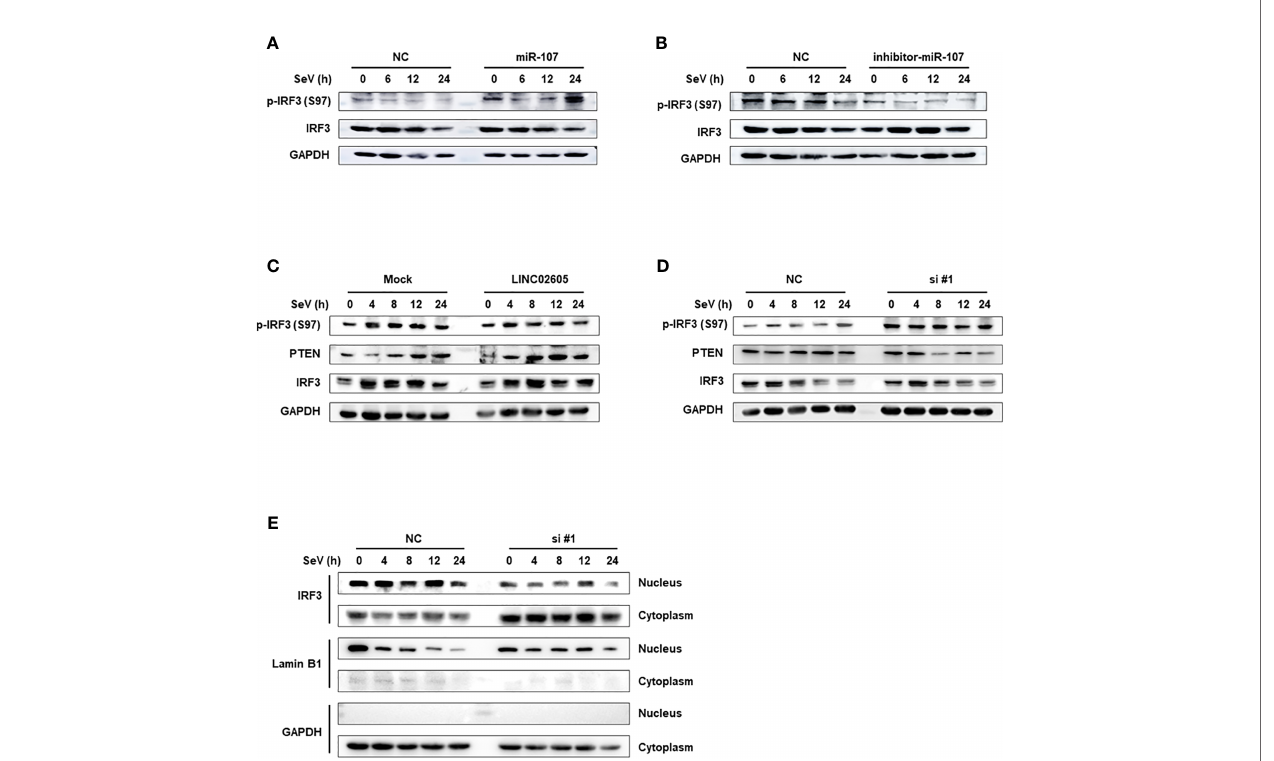
FIGURE 5 | LINC02605 attenuates the phosphorylation level of IRF3 at Ser97 via PTEN and controls the import of IRF3 into the nucleus. (A, B) Western blot analysis of p-IRF3 (S97) and total IRF3 proteins in lysates of hsa-miR-107 mimics (A) or inhibitor (B) transfected HEK293T cells infected with SeV for the indicated hours. (C) Western blot analysis of p-IRF3 (S97) or total IRF3 in lysates of HEK293T cells transfected by ectopically expressed LINC02605 or empty vector with SeV infection for the indicated hours. (D) Western blot analysis of p-IRF3 (S97) or total IRF3 in lysates of NC- and LINC02605-silenced HEK293T cells upon SeV infection for the indicated hours. (E) Western blot analysis of IRF3 expression in nuclear and cytoplasmic fractions in HEK293T cells transfected with NC or si#1 for 24h and then infected with SeV for the indicated hours, followed by nucleus-cytoplasm extraction. All data shown are from one representative experiment of at least three independent repeats with similar